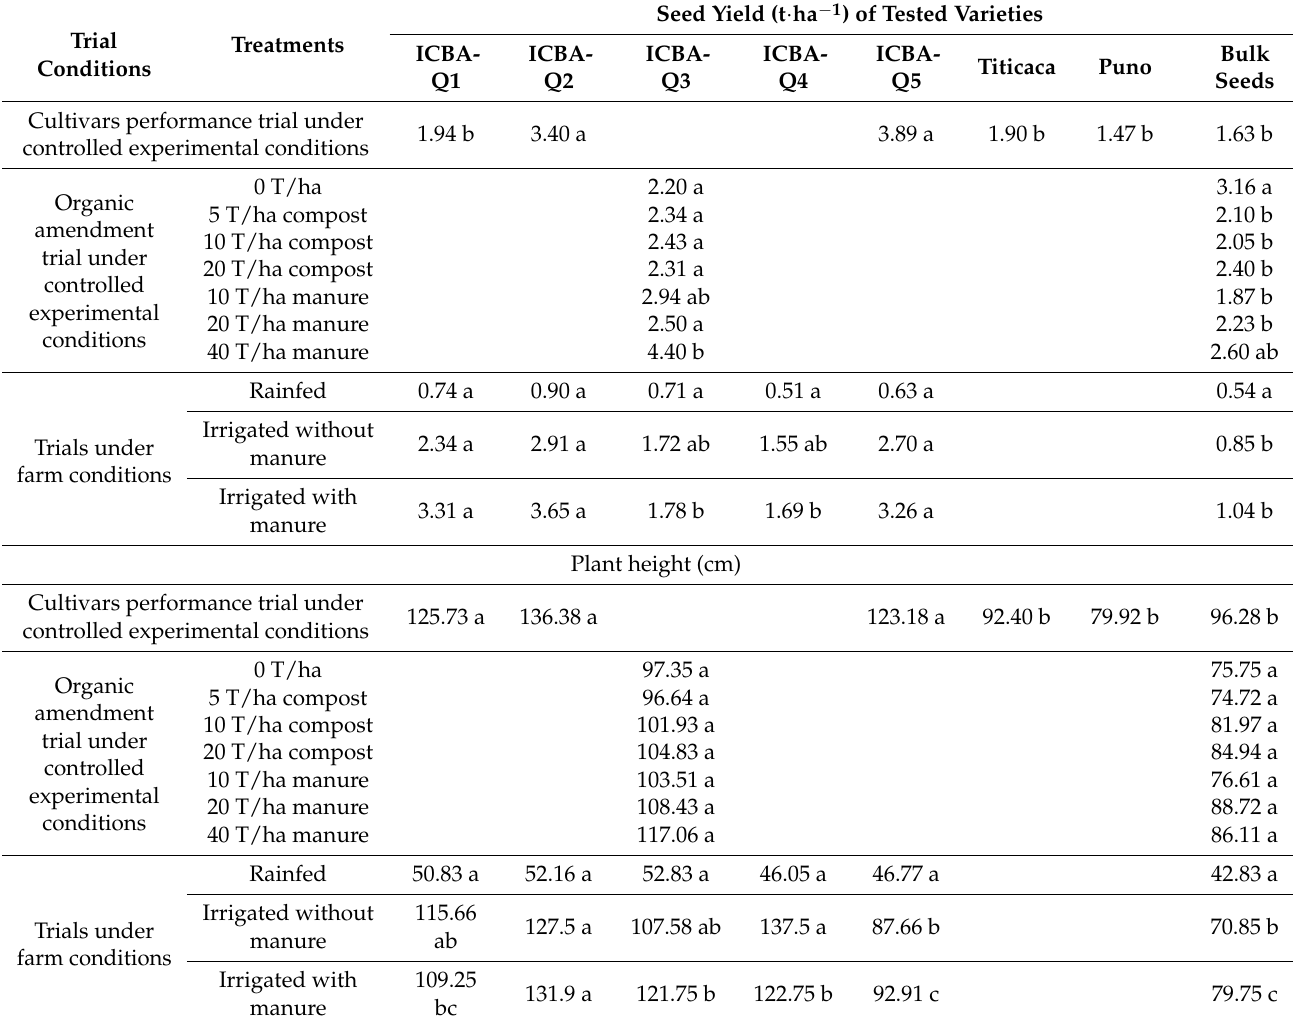
Table 1. Seed yield, plant height, dry matter and 1000 seed weight of quinoa tested in the Rehamna region under several experimental conditions. Different letters (a, b, ab, c) indicate a significant difference according to the Tukey test ( p <